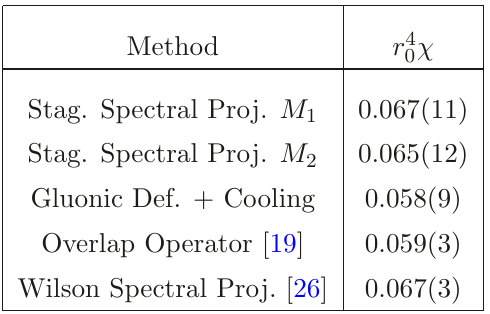
Table 2 . Comparison between various determinations of χ in the continuum for the pure gauge SU(3) theory. The values of M 1 and M 2 are the same reported in table 1.